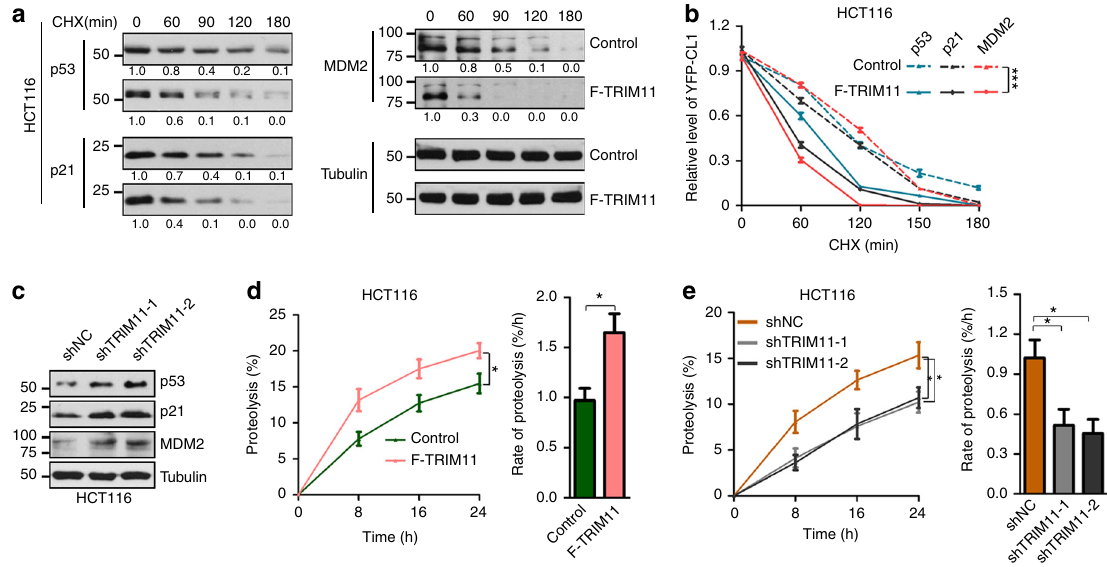
Fig. 2 TRIM11 promotes the degradation of regulatory proteins and enhances overall rate of proteolysis. a , b Half-life of p53, p21, and Mdm2 in control and F-TRIM11-expressing HCT116 cells, assayed by CHX chase assays. Representative western blot of YFP-CL1 ( a ) and the quanti fi cation based on tubulin ( a , b ) are shown. The exposures of the corresponding control and F-TRIM11-expressing blots were adjusted to give similar band intensity at time 0. c Levels of endogenous p53, p21, and Mdm2 proteins in HCT116 cells without and with TRIM11 knockdown. d , e Overall protein degradation in TRIM11 overexpression ( d ), TRIM knockdown ( e ), and the corresponding control HCT116 cells. Cells were cultured in medium with [ 3 H]-Phe and then in medium with non- radiolabeled Phe. [ 3 H]-Phe released into the non-radiolabeled medium at the indicated times was measured, which was plotted as a percentage of total radioactivity incorporated into cellular proteins (left). Rate of proteolysis was calculated from the linear slopes at 8 h (right). In b , d , and e , data represent the mean ± SEM ( n = 3). * P < 0.05; *** P < 0.001. Uncropped blots are presented in Supplementary Fig.